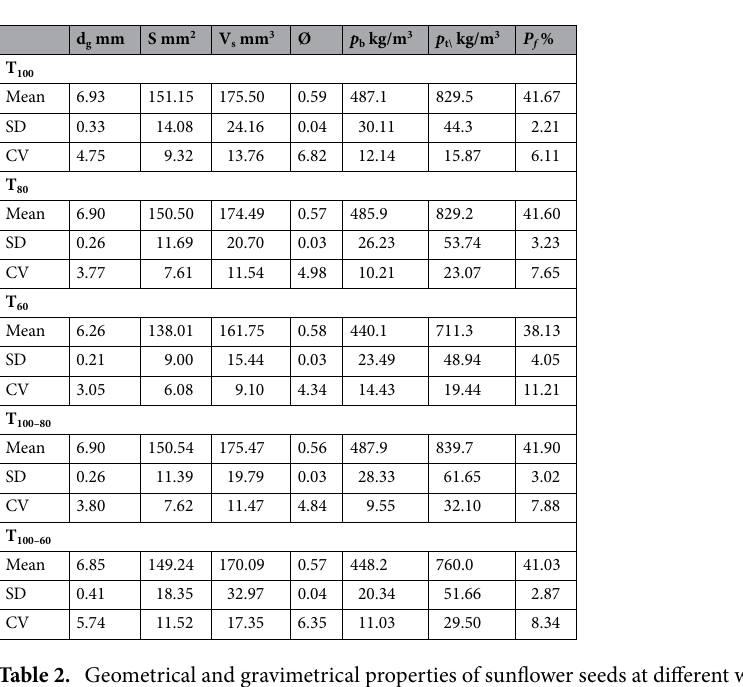
Table 2. Geometrical and gravimetrical properties of sunflower seeds at different water treatments. The geometrical diameter